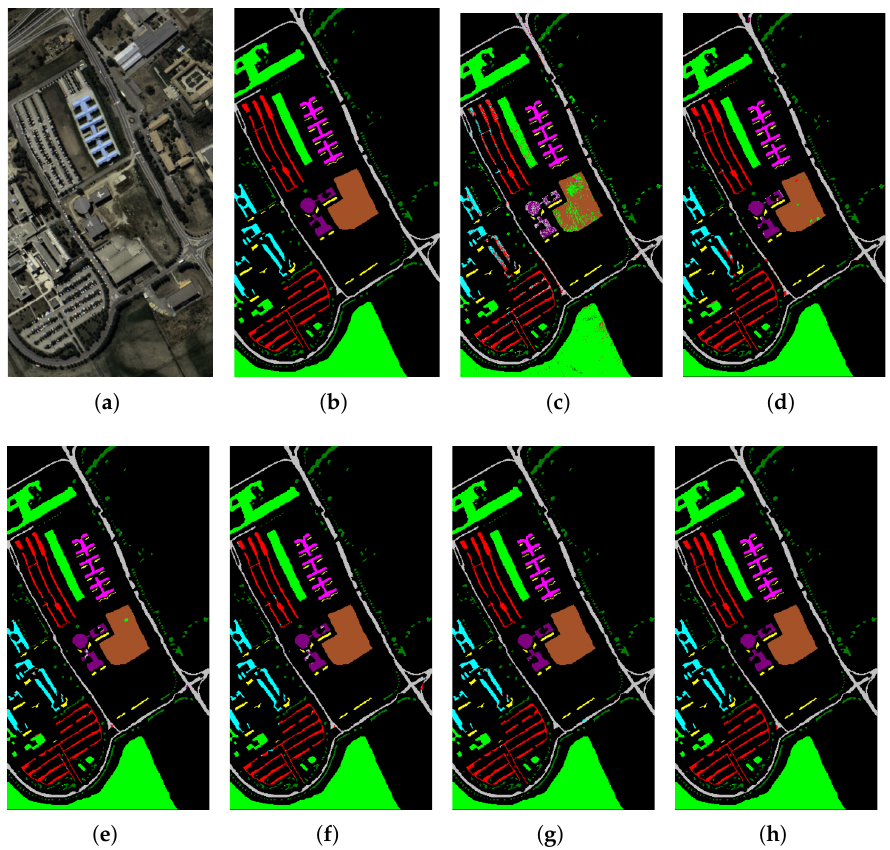
Figure 12. Classification performance of different network models over UP dataset. ( a ) False-color image. ( b ) Ground truth. ( c ) SVM. ( d ) 3-D CNN. ( e ) FDMFN. ( f ) DenseNet. ( g ) PresNet. ( h )